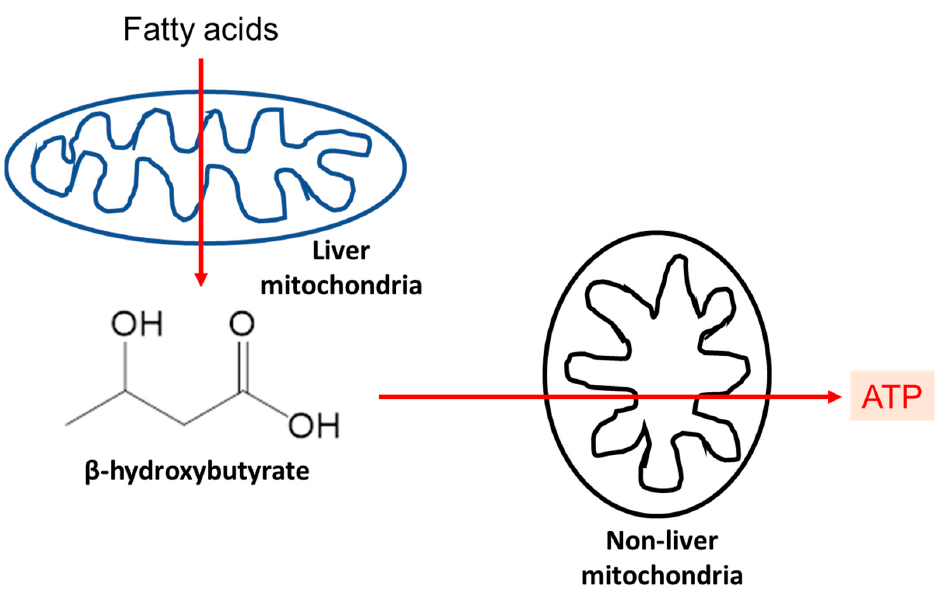
Figure 2. Production of ketone bodies in the liver and their use as energy sources by other organs. Mainly depicted ketone body here is β -hydroxybutyrate, as this is the major ketone body species that is used for signaling and energy purpose. This fi gure is based on reference [20].